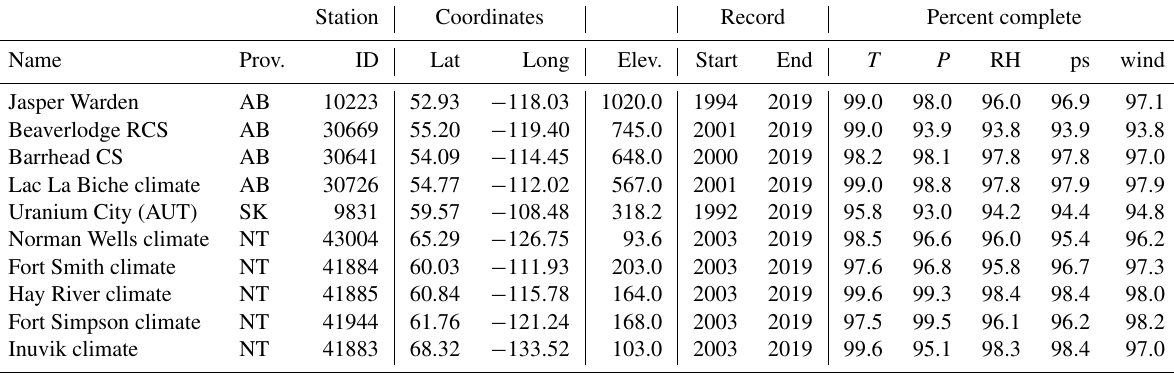
Table 1. List of observation stations used for validating the various gridded historical products. Station